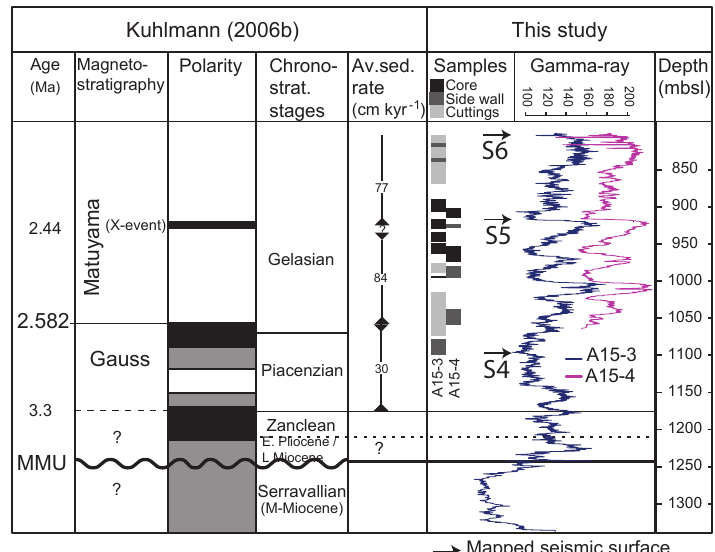
Figure 2. Chronology and mean sedimentation rates as derived from biostratigraphy and paleomagnetic data (Kuhlmann et al., 2006a, b) in combination with the gamma-ray log of A15-3 and A15-4 used in this study on a common depth scale. The position of various sample types and the mapped seismic horizons S4–6 (Fig. S1) are indicated. Material for the sidewall cores is limited and used only for palynology and organic geochemistry. Bioevents based on Kuhlmann et al. (2006a, b) are listed in Table